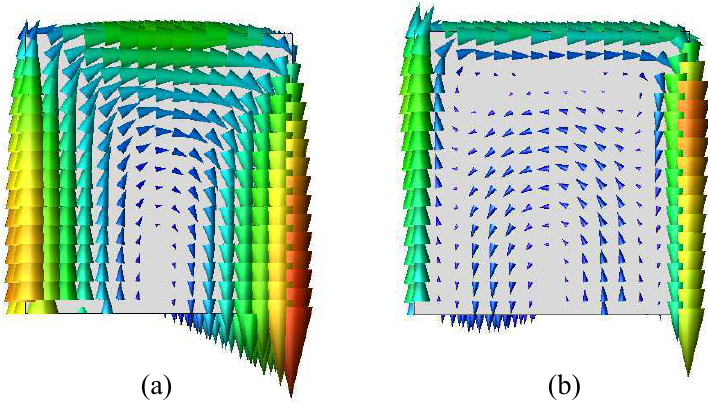
t = π /4 with t = π /4 with m m